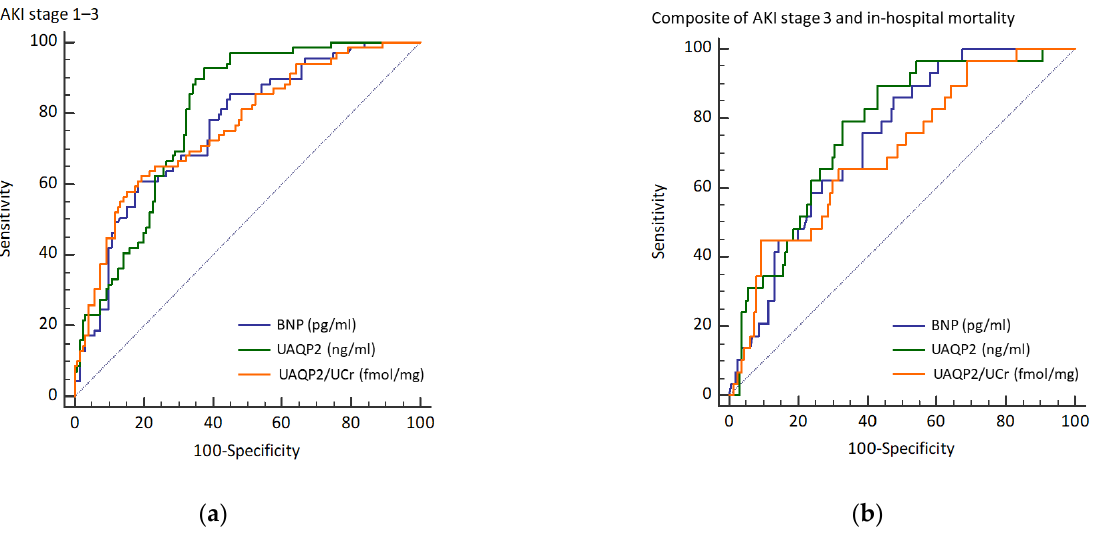
Figure 2. Receiver operating characteristic curves of BNP, UAQP2, and UAQP2/UCr discriminating ( a ) AKI and ( b ) composite of AKI stage 3 and in-hospital mortality. Abbreviations: BNP, brain na- triuretic peptide; UAQP2, urinary excretion of aquaporin 2; UCr, urine creatinine. Table 4. Discriminating between AKI and the composite of AKI stage 3 and in-hospital mortality: receiver operating characteristic curve analysis of the biomarkers of heart failure and renal dysfunc- tion.